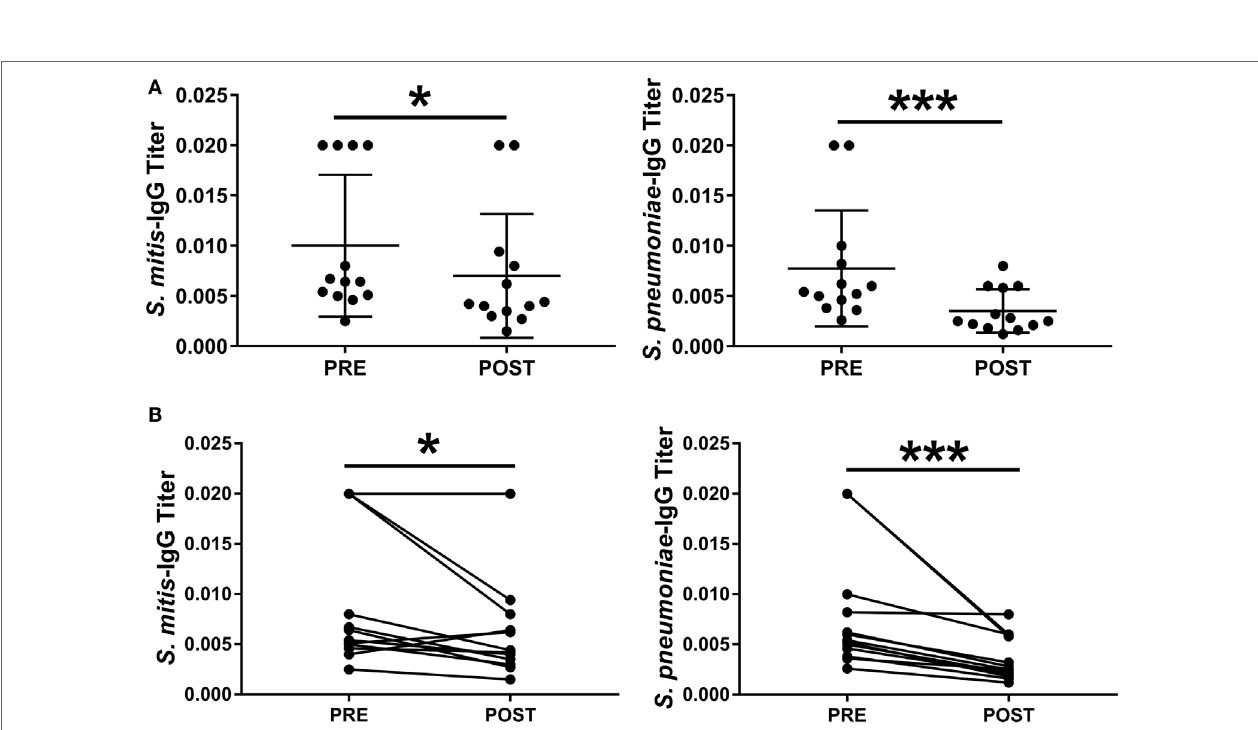
FigUre 5 | Levels of Streptococcus mitis - and Streptococcus pneumoniae -reactive IgG antibodies isolated from S. pneumoniae 6B-inoculated adults. Pre- and post-inoculation plasma samples were collected from 13 individuals inoculated with S. pneumoniae 6B. Serially diluted plasma samples were added to wells in duplicate. The OD values were converted to titers, with a cutoff value of 0.20 (see legend to Figure 2 ). The levels of IgG antibody titers against S. mitis and S. pneumoniae strains are shown. OD values are shown for each subject at pre- and post-challenge time points. (a) Pre- and post-challenge IgG levels to S. mitis and S. pneumoniae 6B. (B) Pre- and post-challenge IgG levels to S. mitis and S. pneumoniae 6B linked for each subject. Wilcoxon Signed Rank Test, * p < 0.05; *** p < 0.001. Abbreviations: PRE, pre-inoculation sera; POST, post-inoculation sera.